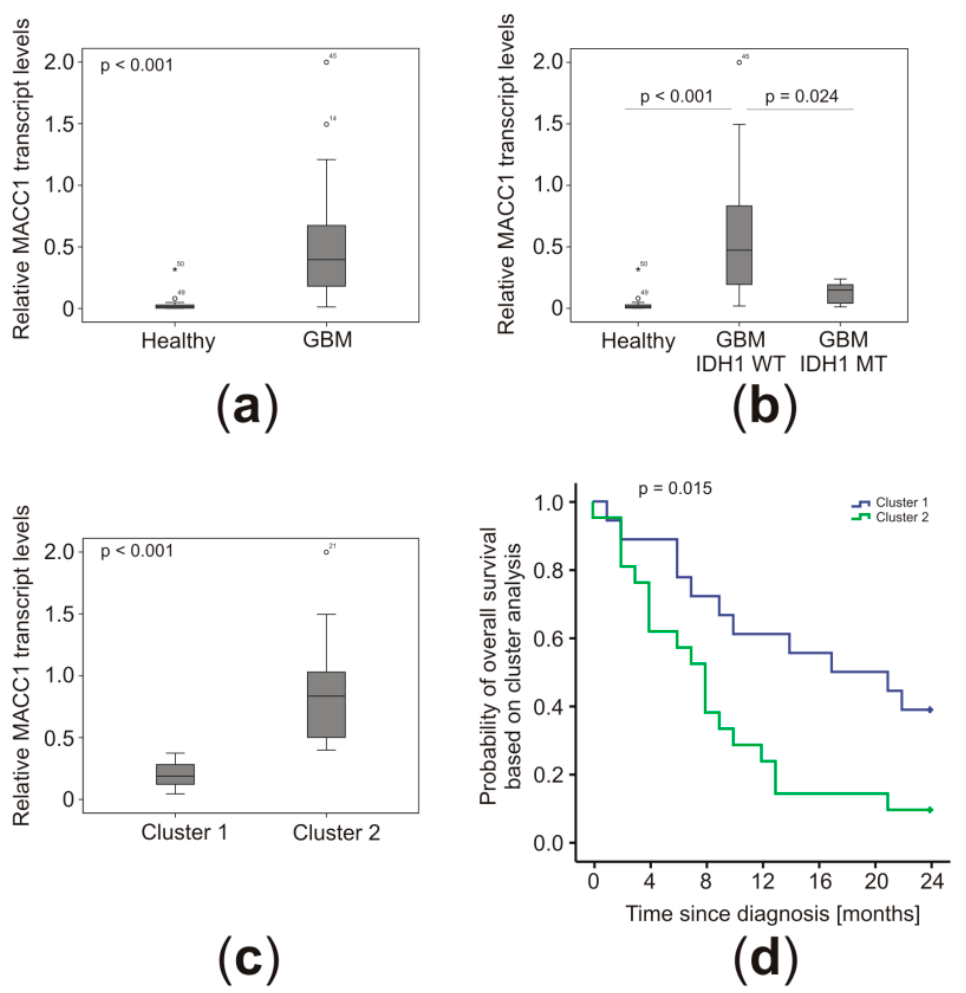
Figure 1. Metastasis-associated in colon cancer-1 (MACC1)-transcript levels in the plasma of GBM patients correlated with disease grade and survival. MACC1 plasma levels were determined by quantitative RT-PCR (in duplicates). ( a ) Comparison of all GBM patients ( n = 45) with healthy